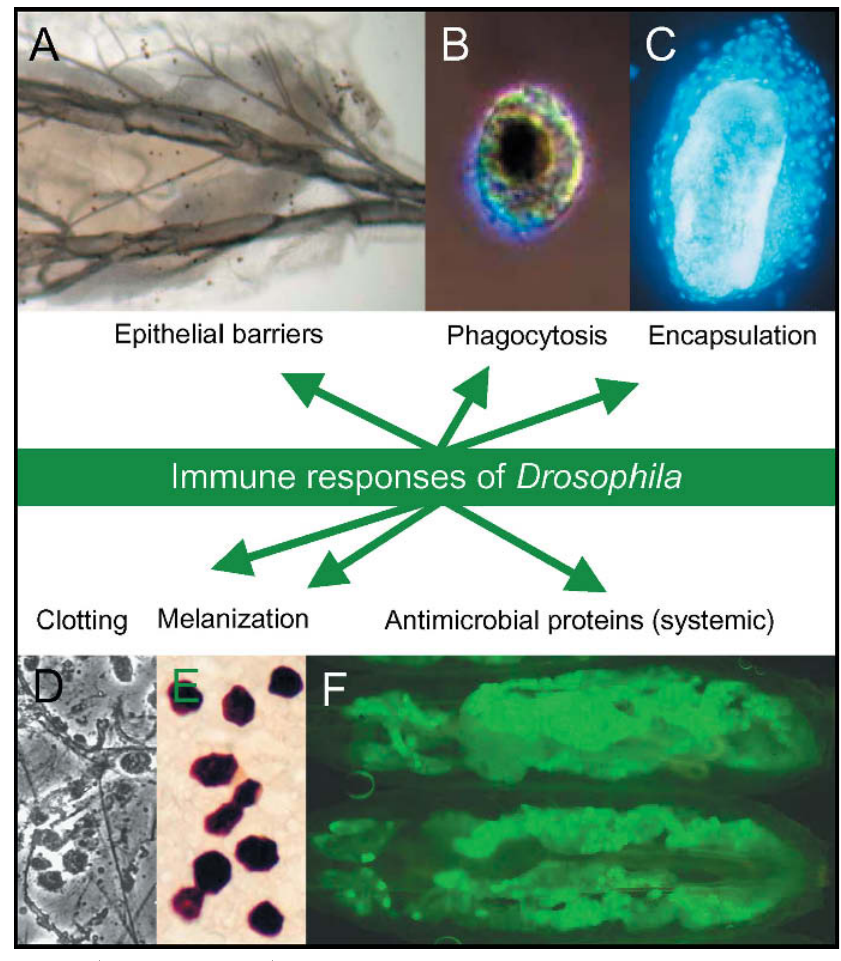
Figure 1. Innate Immune Responses of Drosophila (A) Posterior region of a third instar larva showing the cuticle and the trachea. These structures provide a physical barrier against infections. Cellular immune reactions consist of phagocytosis, encapsulation, and melanization. (B) A dead and melanized crystal cell phagocytosed by a plasmatocyte. (C) Encapsulation of an egg of a Drosophila parasite. The parasite is a wasp that normally infects larvae. Cells surrounding the egg are lamellocytes. The cells and the egg are stained with a fl uorescent nuclear stain. (D) Clot formation occurs during wound healing. (E) Crystal cells in contact with the larval cuticle. The contents of the crystal cells are melanized. Melanization occurs in response to intruding pathogens or parasites and is also observed during wound healing. (F) Humoral immune reaction. The expression of antimicrobial peptides in the larval fat body is induced by microbes. Cells of the fat body appear green due to the presence of a transgene encoding the green fl uorescent protein, under the control of the drosomycin promoter. The drosomycin promoter is activated in response to fungal infections and is under the control of the Toll pathway (see Figure 2). Antimicrobial peptides are released from the fat body into the hemolymph. This response is therefore systemic. A similar antimicrobial gene activation response can occur locally in specifi c body parts such as the trachea or the gut (not